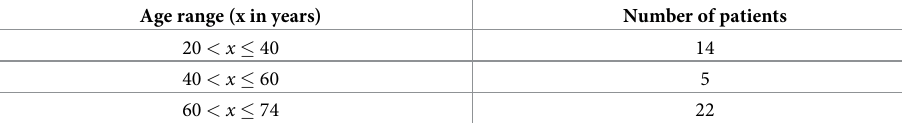
Table 3. Age distribution of the 41 individuals from [54–56].